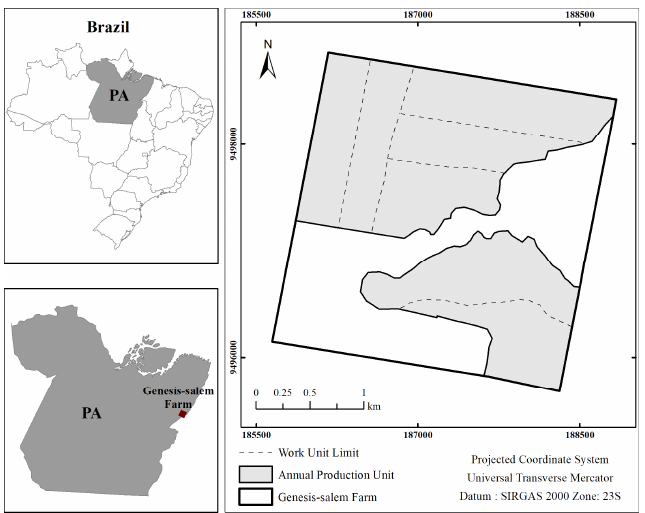
Figure 1. Location and description of G ê nesis-Sal é m Farm, Par á (PA),